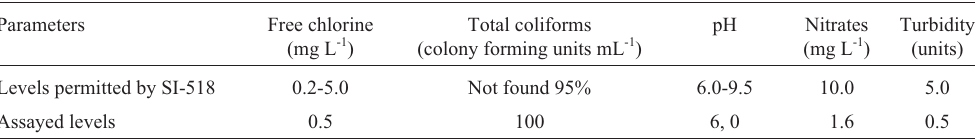
Table 1 - Chemical and bacteriological analysis performed on treated drinking water obtained from the Pitimbu river. The analysis was performed by the Rio Grande do Norte Water and Sewage Company (Companhia de Águas e Esgotos do Rio Grande do Norte) using the water purification criteria of the Brazilian Health Ministry Statutory Instrument 518